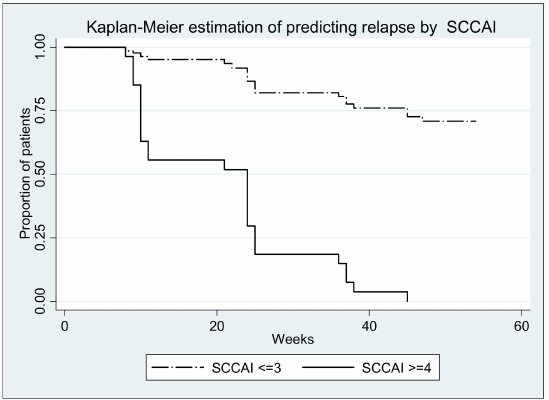
Figure 9. Log-rank test for equality of survivor functions (SCCAI) p < 0.00001.